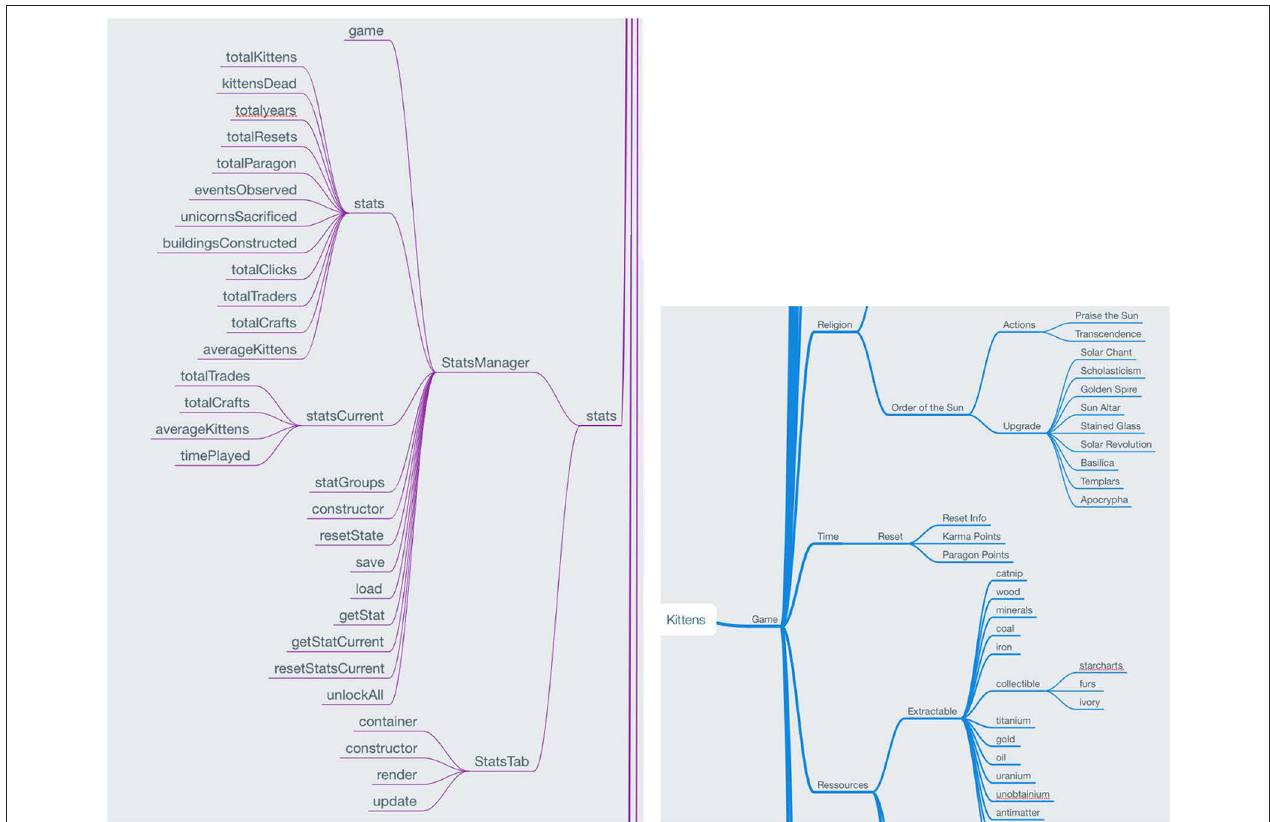
FIGURE 2 | Partial view on the objects who are part of Kittens Game . The left side depicts objects as represented in the code structure whereas the right side lists objects as presented to a potential player at a certain